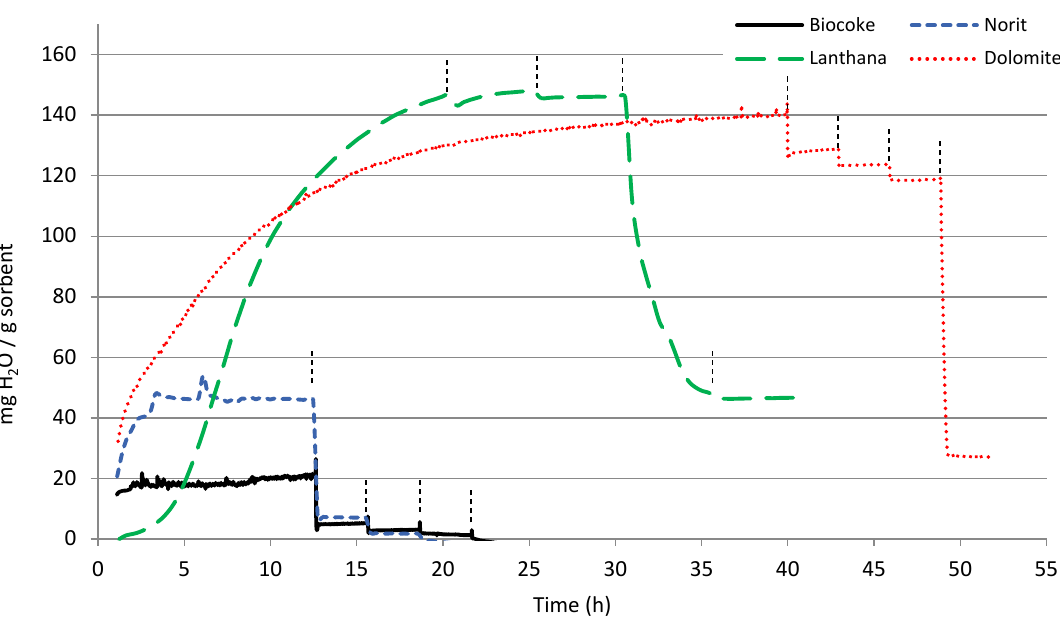
Figure 3. Water sorption capacity of the calcined lanthana, dolimite, biocoke and commercial activated carbon Norit. The vertical lines in each graph indicate the temperature change: 25 °C, 100 °C, 200 °C, 300 °C and 400 °C.